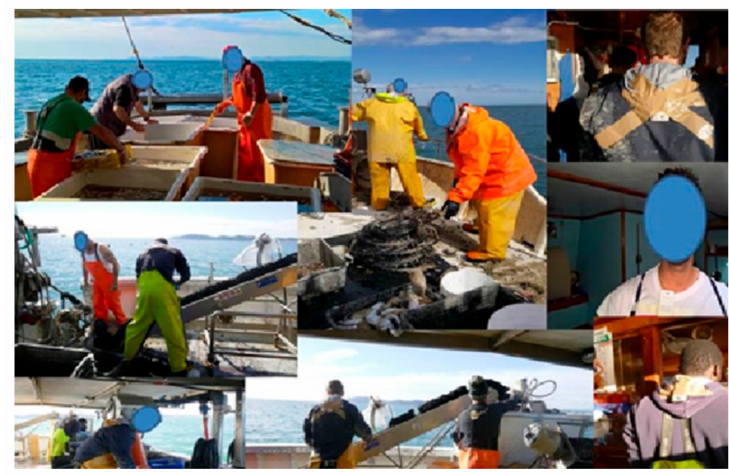
Figure 2. Placement of the personal UV dosimeters in the group of fishermen in di ff erent boats.